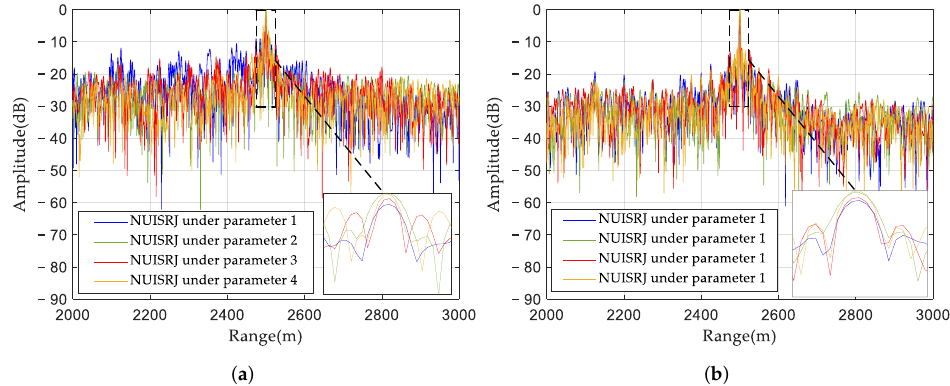
Figure 13. Comparison of pulse compression results after using different methods to suppress NUISRJ: ( a ) Ref. [20]’s method, ( b ) Ref. [19]’s